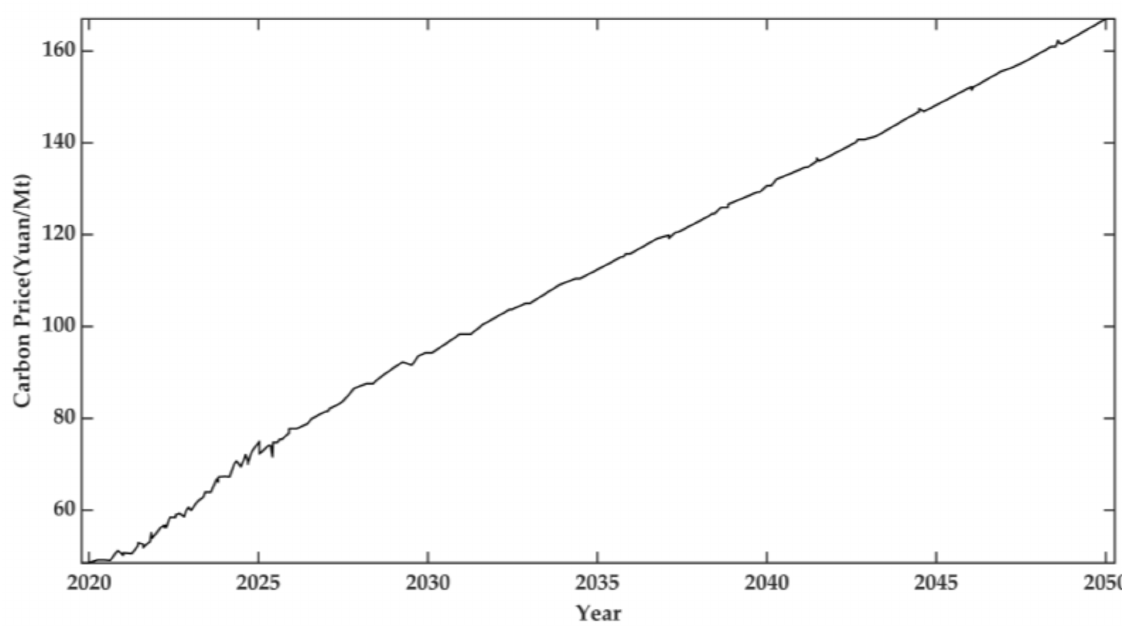
Figure 5. The expected price of the national carbon emissions trading market in